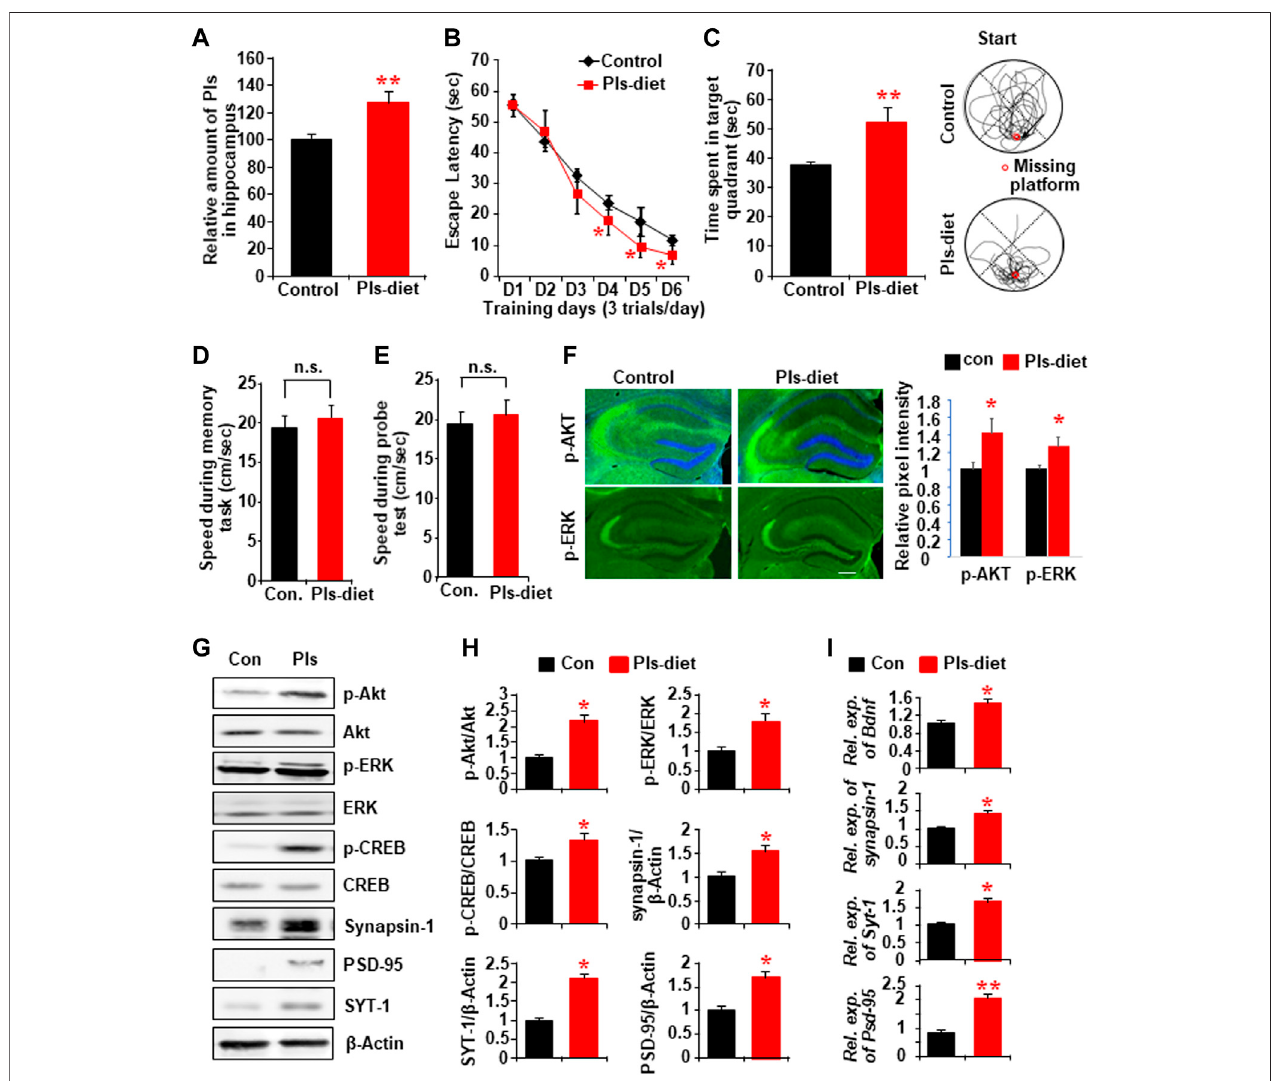
FIGURE3| ImpactofPlsdietinspatialmemoryandmemory-relatedproteinexpression inthehippocampus. (A) Massspectroscopic datashowtheexpressionof hippocampal Pls in the mice fed with the diet containing 0.01% Pls for 6 weeks (0.2 – 0.25 mg Pls/day/mouse, n = 5). (B) Memory tasks show the change in escape latency by Pls diet. (C) The probe test following the memory task shows the changes of time spent in the target quadrant. The right panel shows examples of traces for control(upper)andPlsdiet(lower)mice.Theredcircleindicatestheplaceofthemissingplatform. (D,E) Theswimmingspeedofthemiceinbothgroupsduringthe memorytasks (D) andtheprobetests (E) . (F) Immunohistochemistrydatashowtheexpressionofp-Aktandp-ERKinthecontrolandPlsdietmicehippocampus.Scale bar, 300 μ m. The right panel shows the image intensities in relative pixel values. (G) Representative Western blotting assays show the protein expression in the control andPlsdietmicehippocampustissue. (H) Quanti fi cationdataofthepanel (G) showtherelativechangeintheexpressionofp-Akt,p-ERK,p-CREB,synapsin-1,PSD-95,and SYT-1bythePlsdietinthemicehippocampus( n =5). (I) Real-timePCRdatashowthemRNAexpressionof Bdnf , Synapsin-1 , Syt-1 ,and Psd-95 inthemicehippocampus ( n = 5).The datarepresentmean±S.E.M.*, p < 0.05and **, p < 0.01. The p valuesofpanelBwereobtainedfromANOVAanalysisfollowedbyposthocBonferroni ’ s tests. Student ’ s t-tests were performed in panels (D,E,F,H,I) .